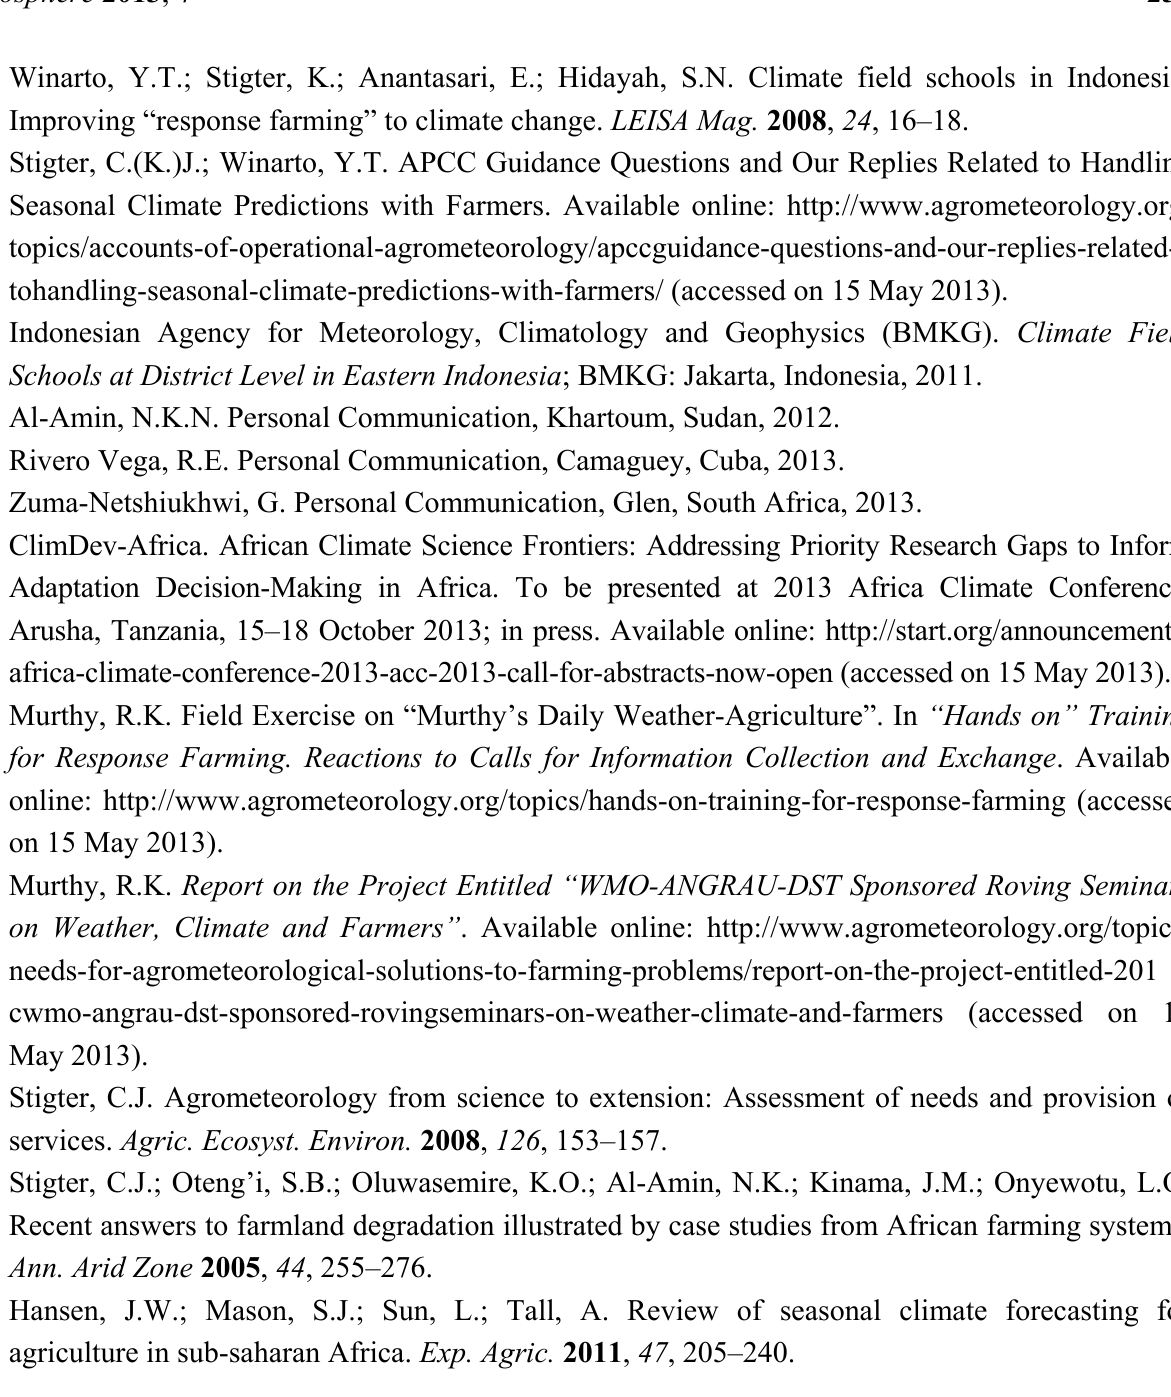
A1. Set up of syllabus to train agrometeorological extension trainers (product